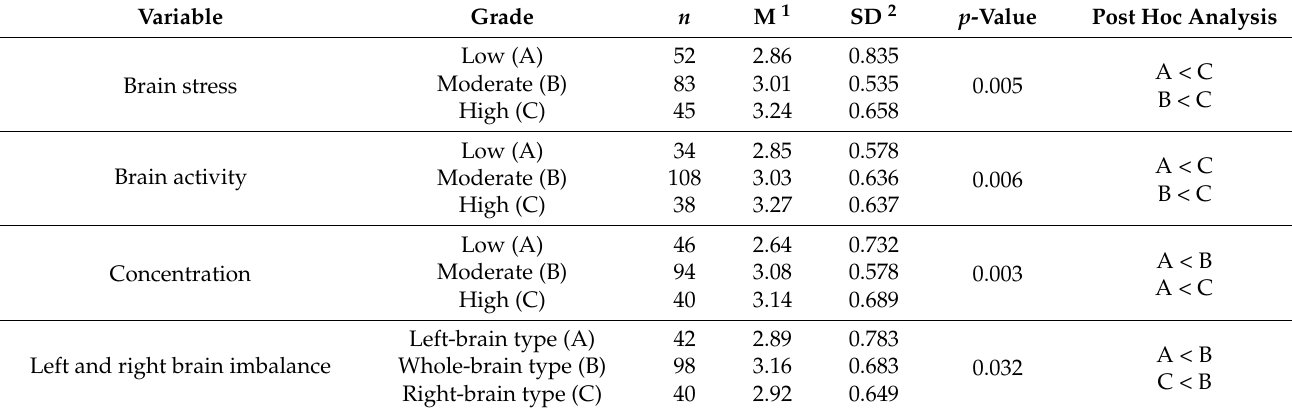
Table 6. Statistical analysis results for differences in safety commitment according to brain wave